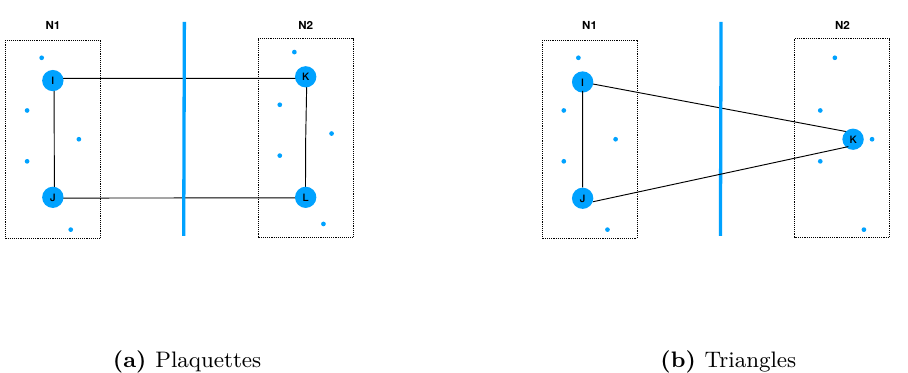
Figure 3. Example of a triangle and plaquette that contribute to the ground state wavefunction. The branes I and J are in the visible